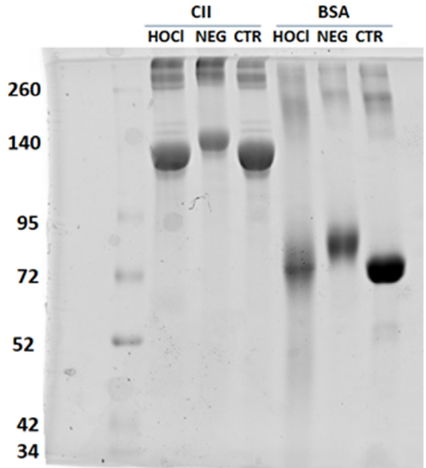
Figure A1. SDS-PAGE analysis of the HOCl-CII and NEG-CII compared with the unmodified CII and the control changes in BSA. The numbers on the left indicate the marker MW (kDa).